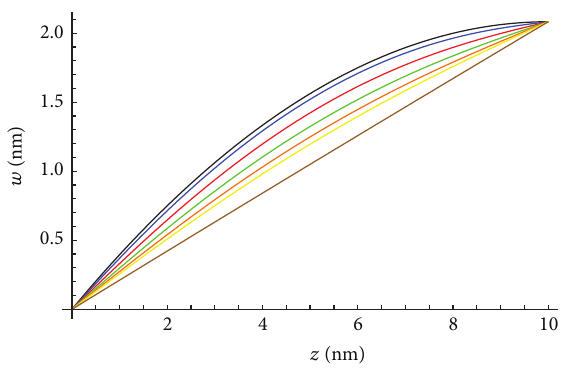
Figure 2: Axial displacement field 𝑤 for 𝑐 = 0 (local solution—black line), 𝑐 = 1 nm (blue line), 𝑐 = 2 nm (red line), 𝑐 = 3 nm (green line), 𝑐 = 4 nm (orange line), 𝑐 = 5 nm (yellow line), and 𝑐 = 25 nm (brown line). 𝐸 = 300 GPa; 𝐿 = 10 nm; 𝐴 = 80 ⋅ 10 −2 nm 2 ; and 𝑝 = 10 −8 N/nm.